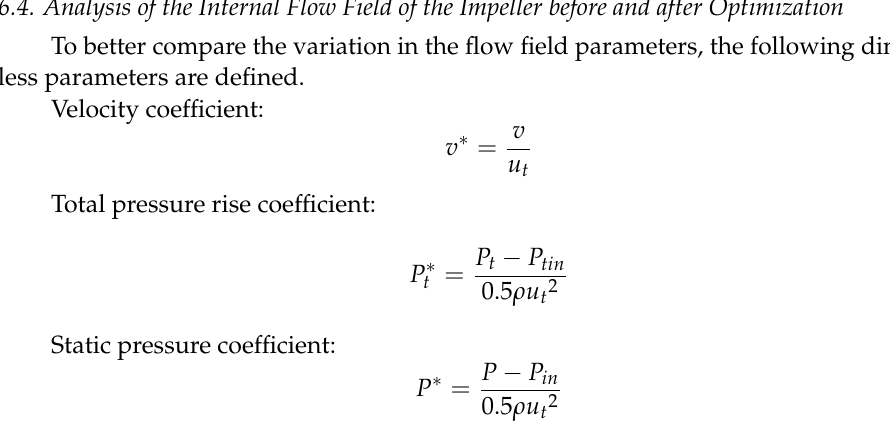
Figure 13. Performance comparison of the pump section before and after optimization.